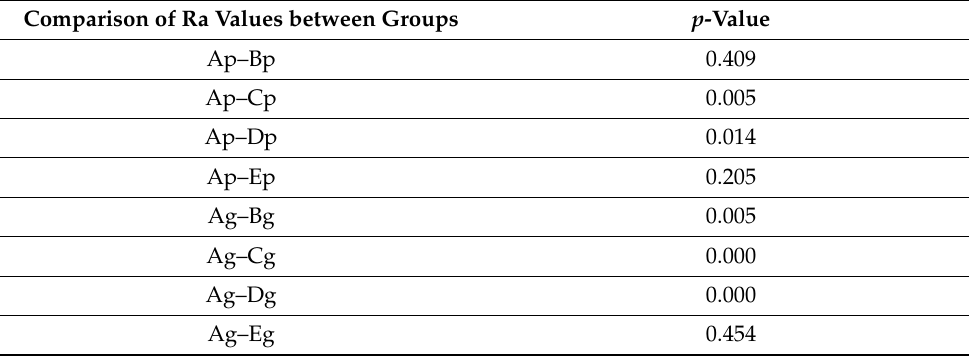
Table 5. p values between groups, related to Ra. Comparison of Ra Values between